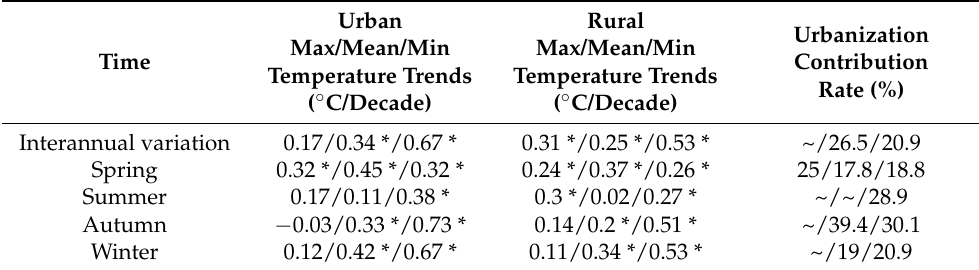
Table 1. Interannual and intraseasonal trends in urban and rural maximum/mean/minimum temper- atures, along with the contribution of urbanization (statistical significance level at the 0.05 is denoted by *, and a tilde (~) indicates that the effect of urbanization failed the 0.05 significance test and no calculation of the urbanization contribution was